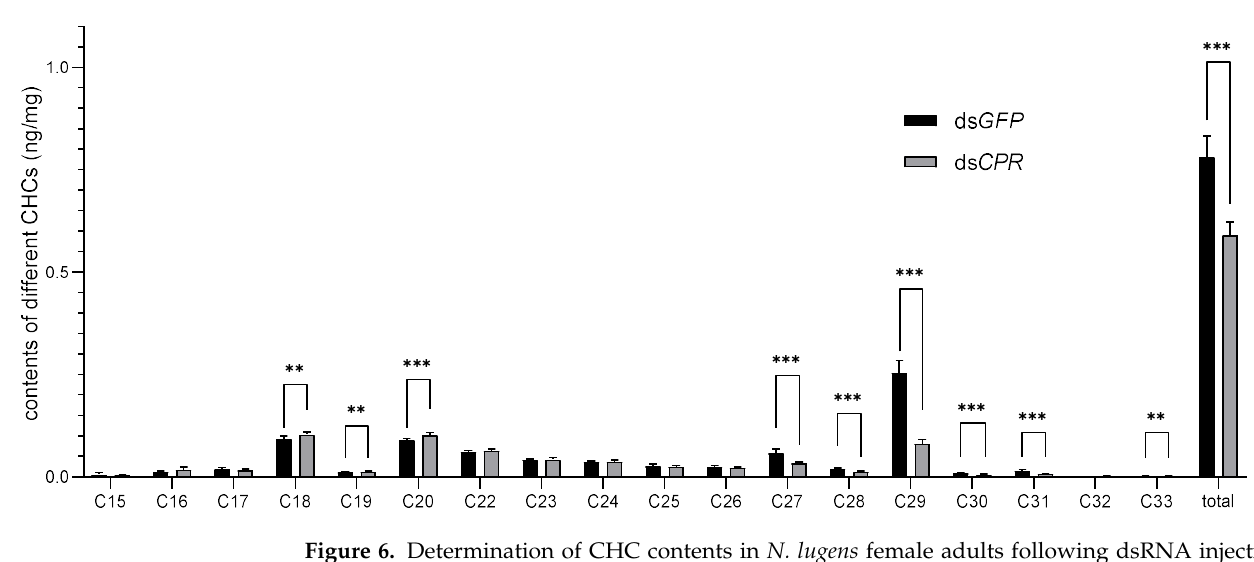
Figure 6. Determination of CHC contents in N. lugens female adults following dsRNA injection. The contents of total hydrocarbons and straight-chain alkanes with different lengths (C15–C33) in female adults were analyzed by GC–MS. The results were calculated from five biological replicates (nanograms per milligram of fresh body mass ± SE). The asterisks ** and *** indicate significant differences at p < 0.01 and p < 0.001 between ds CPR and ds GFP -treatments (Student’s t -test). Table 1. CHC profile of N. lugens female adults.